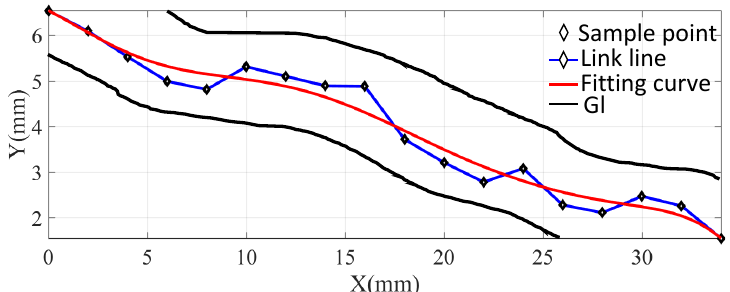
Figure 6. The state of the capsule robot during squirming of the GI. The blue stars represent possible sampled position results. The red line is the curve-fitting result. The black lines represent the GI tract. It can be seen that the red line matches the length of the GI better than the blue